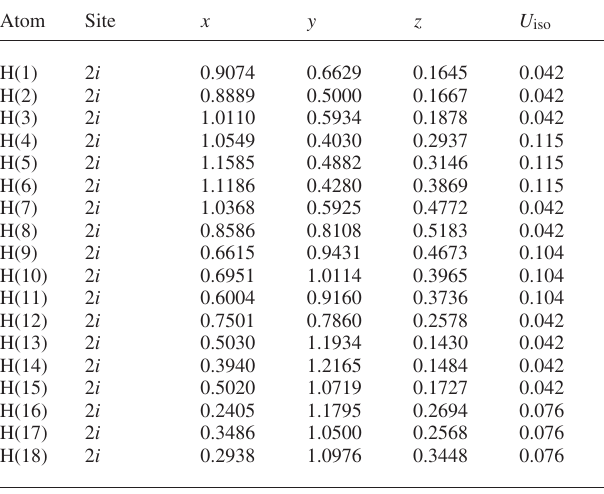
Table 2. Atomic coordinates and displacement parameters (in Å 2 )